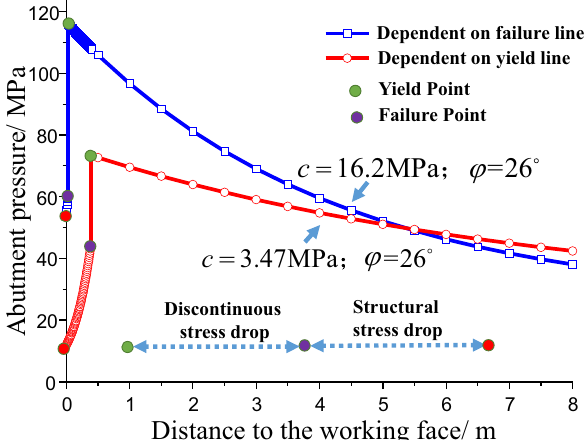
Fig. 3 Comparison of abutment pressure distribution influenced by two